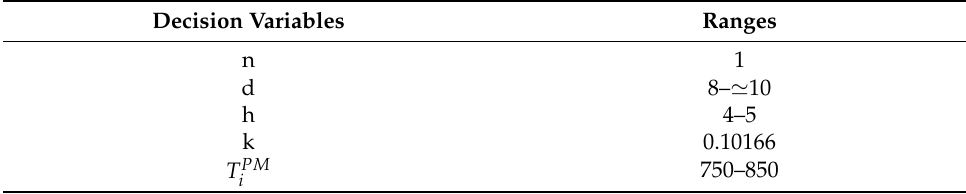
Table 4. Ranges of optimal values for the five decision